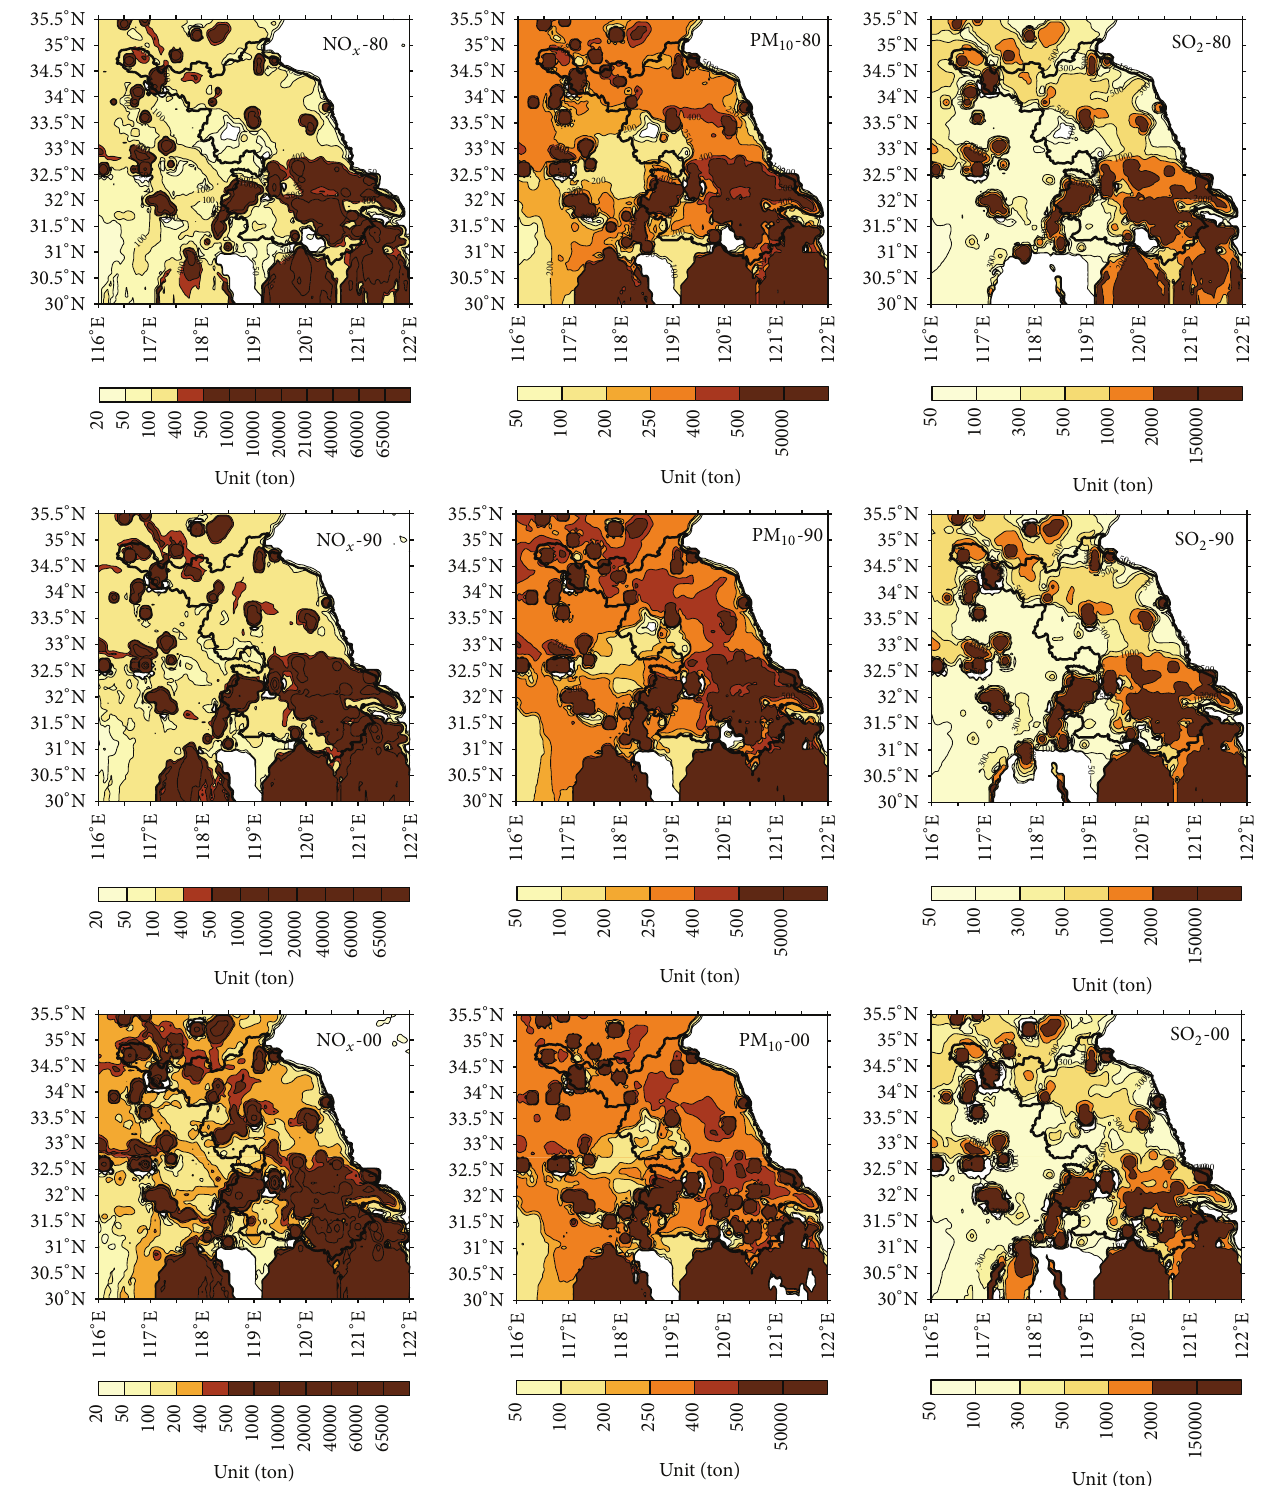
Figure 9: Decadal changes of NO 𝑥 , PM 10 , and SO 2 emissions in Jiangsu Province and neighboring areas (yearly